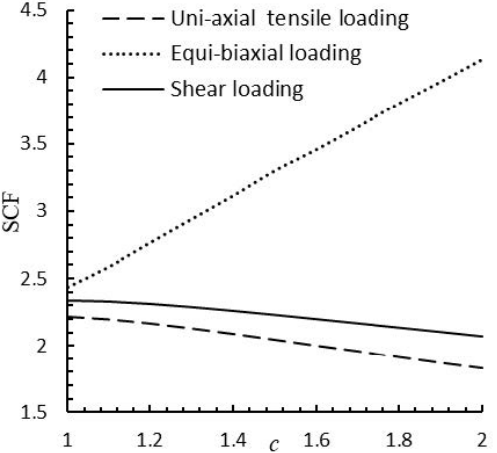
Figure 18. Variations of the SCF with c in different types of loadings ( w = 0.05).